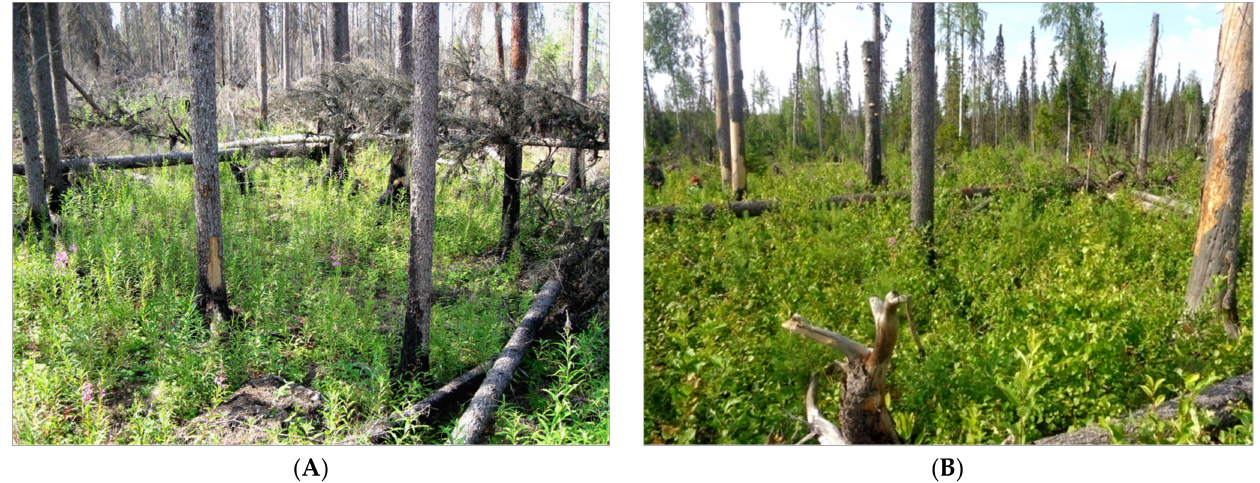
Figure 4. Pristine spruce forest burnt by high-severity fire in SP 9 in 2014 ( A ) and in 2020 ( B ). Overall, by 2020 the percentage cover of downed deadwood in plots after medium- severity fire increased 1.6–2-fold and in heavily affected plots the increase was 3-fold.